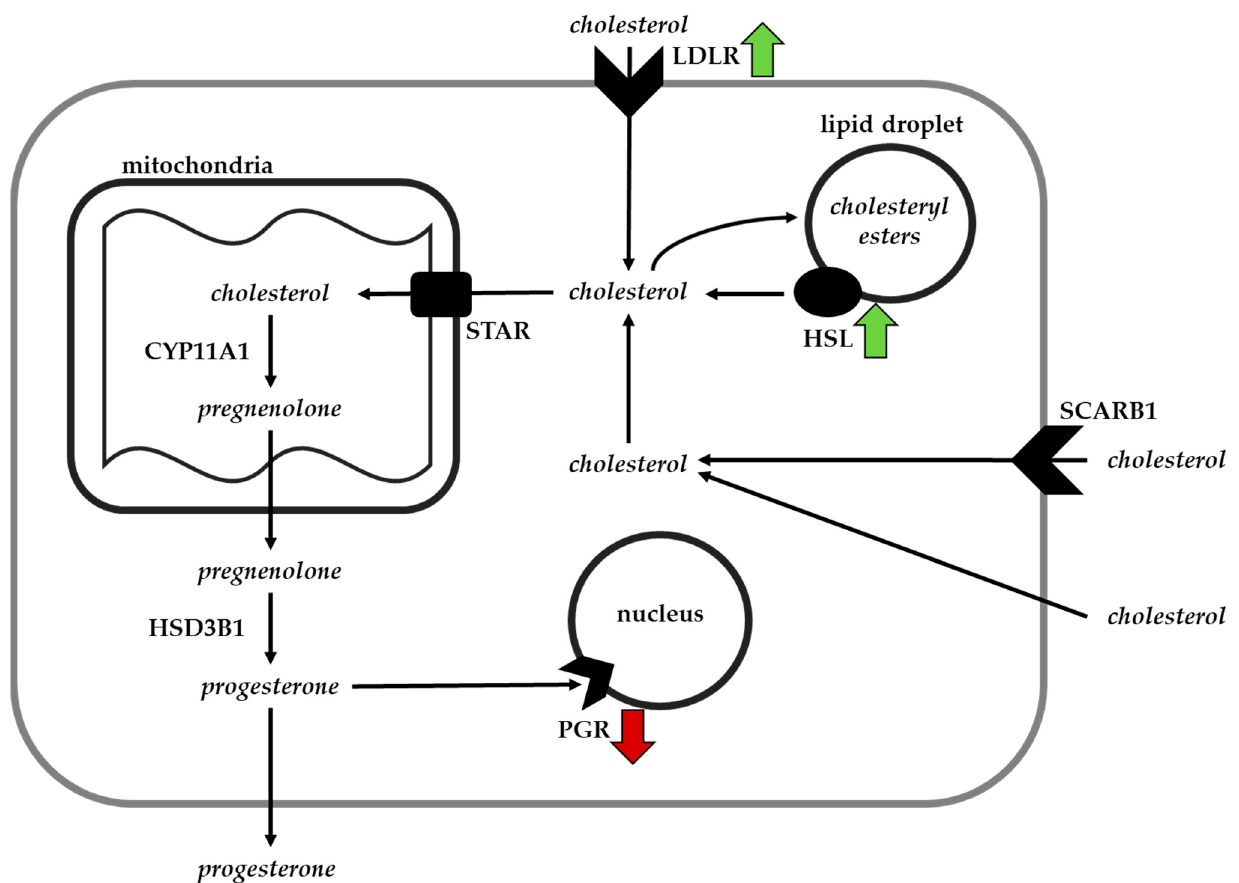
Figure 7. Mechanism of the availability of cholesterol and steroidogenesis in a steroidogenic luteal cell, emphasizing the four potential sources of cholesterol that are available as a substrate. Each arrow represents a significant difference in the abundance of mRNA associated with each respective protein. The arrow pointing upward or downward indicates that the mRNA is significantly upregu- lated (green) or downregulated (red) respectively in the MIX treatment group compared to the ISe treatment group.